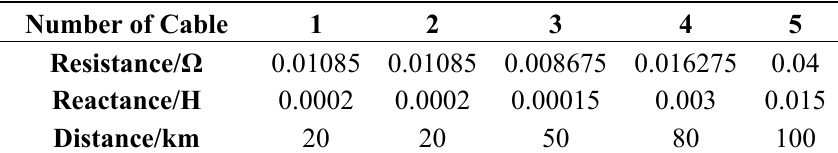
Table 1. Parameters of DC Cables.